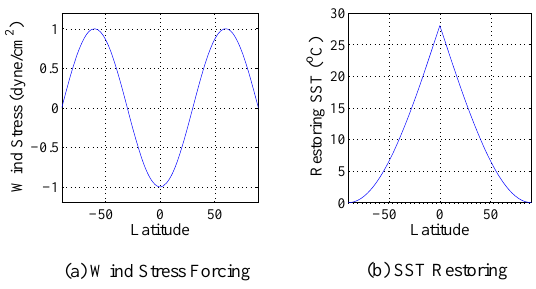
Figure 9. Analytical wind stress and surface heat